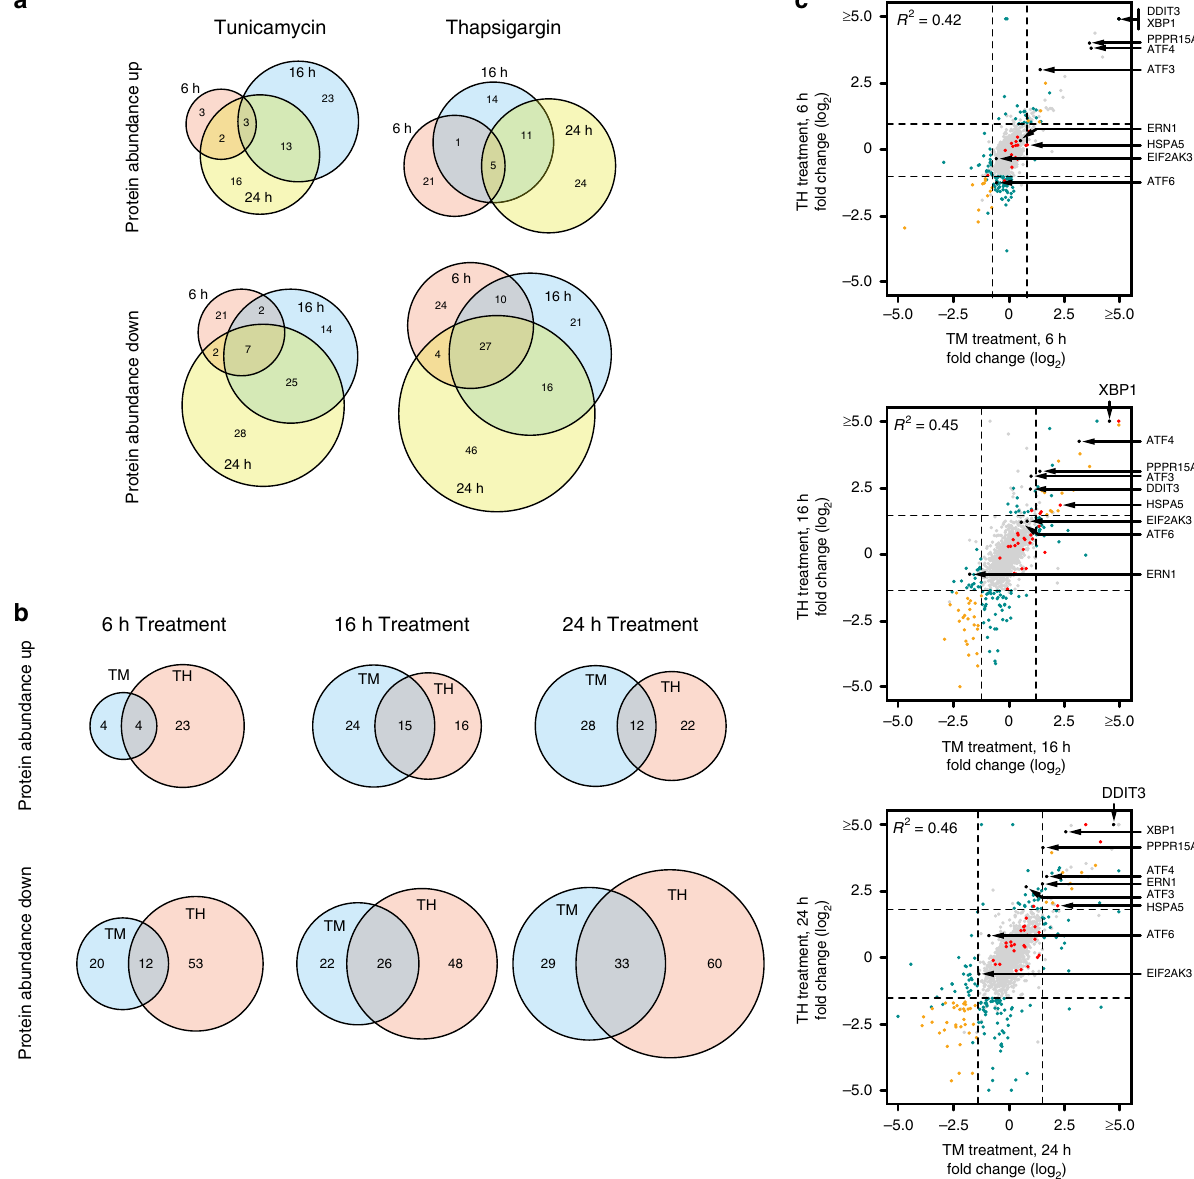
Fig. 3 UPR-induced changes to the cellular proteome. a Time-resolved comparison of changes to protein abundance after TM treatment (left) or TH treatment (right). b Comparison of TM and TH-induced changes to protein abundance after 6, 16, and 24 h of treatment. c Comparison of mean values of protein abundance changes 6 h (top panel), 16 h (middle panel), and 24 h (bottom panel) after stimulation with either TH or TM. Data from shotgun proteomics are color-coded as in Fig. 1. Additional data points from a targeted proteomics approach 30 are shown as black dots. Select proteins involved in the UPR are marked by arrows. (see also Supplementary Fig. 5 and Supplementary Data 4). Two criteria were used to fi lter for regulated genes: a fold- change median ± 2 * standard deviation (as indicated by the dashed lines), and a P -value threshold